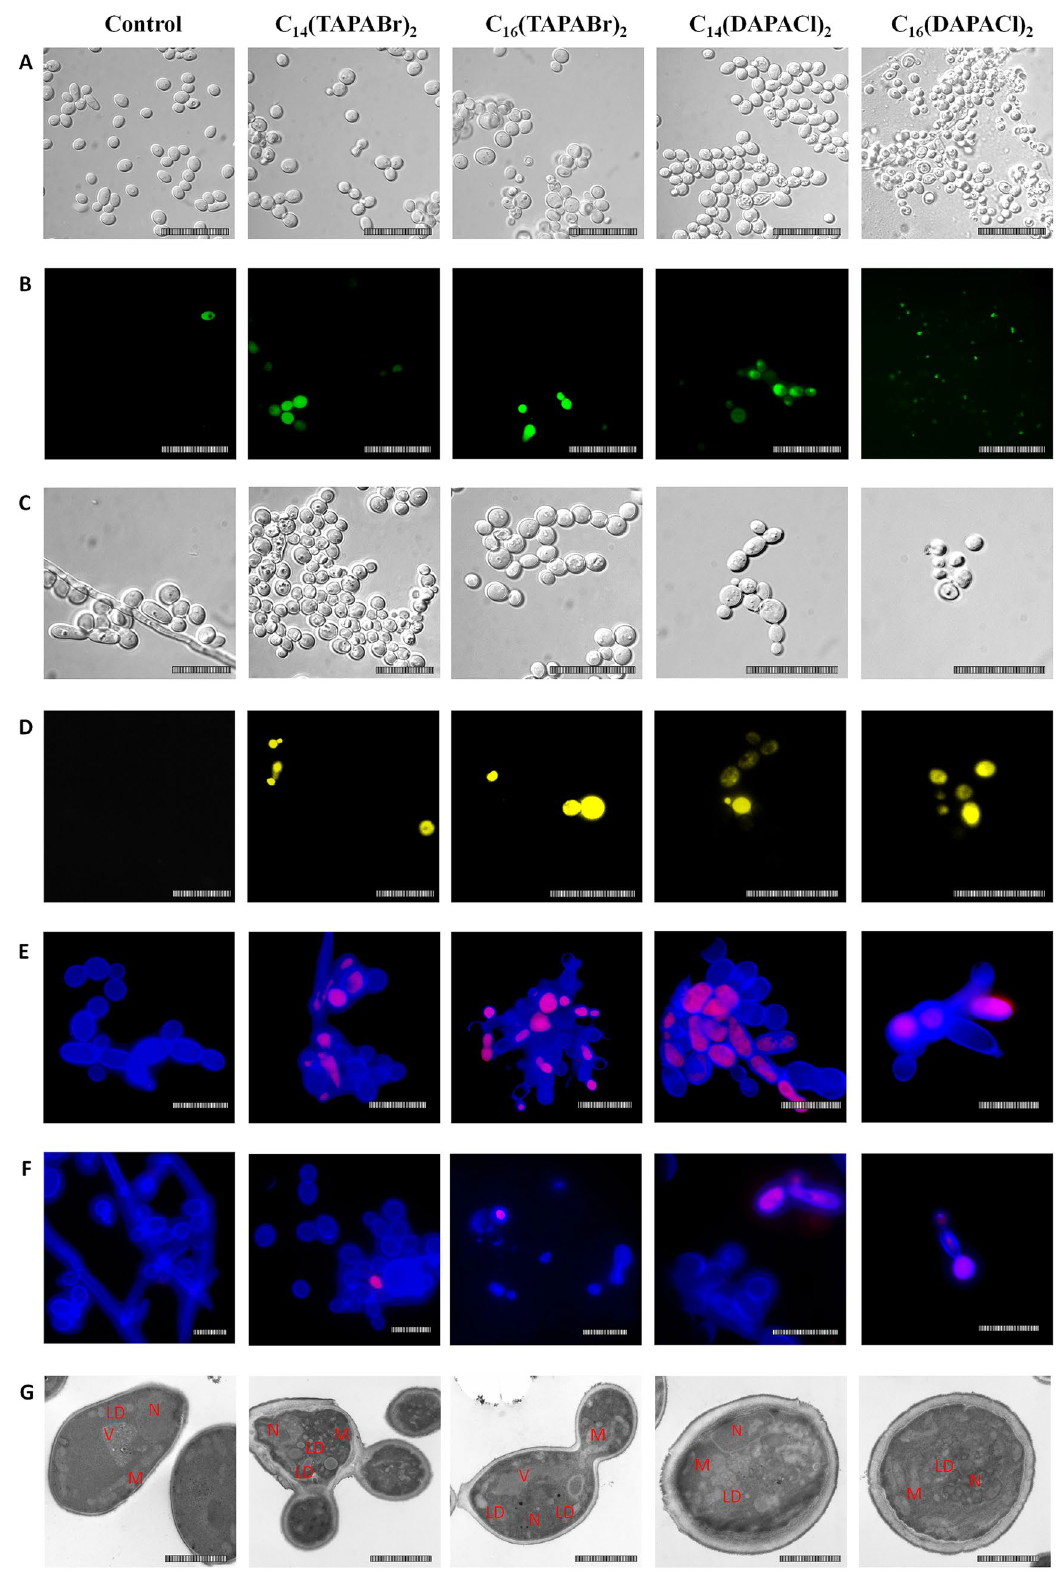
Figure 3. The summary illustration of the presence of intracellular oxidative stress and membrane continuity in yeast cells under the influence of the tested surfactants: general oxidative stress (green cells) ( A , B ), production of superoxide anion (O 2 ·−) (yellow cells) ( C , D ) and cells with mitochondrial oxidative stress (red cells) ( E ), cells with disrupted membrane continuity show red fluorescence ( F ). DIC microscopy ( A , C ), fluorescence microscopy using staining: 2 ʹ ,7 ʹ -dichlorohydrofluorescein ( B ), dihydroethidine ( D ), Calcofluor White M2R + Mitosox Red mitochondrial superoxide indicator ( E ), Calcofluor White M2R + Sytox Green Dead Cell ( F ) and TEM ( G ). Morphology of C. albicans cells under the influence of the studied surfactants in TEM. Notation used in the figure: N nucleus, V vacuoles, LD lipid droplets, M mitochondrion, ER endoplasmic reticulum; scale bars ( A – F ) = 10 μm and ( G ) = 500